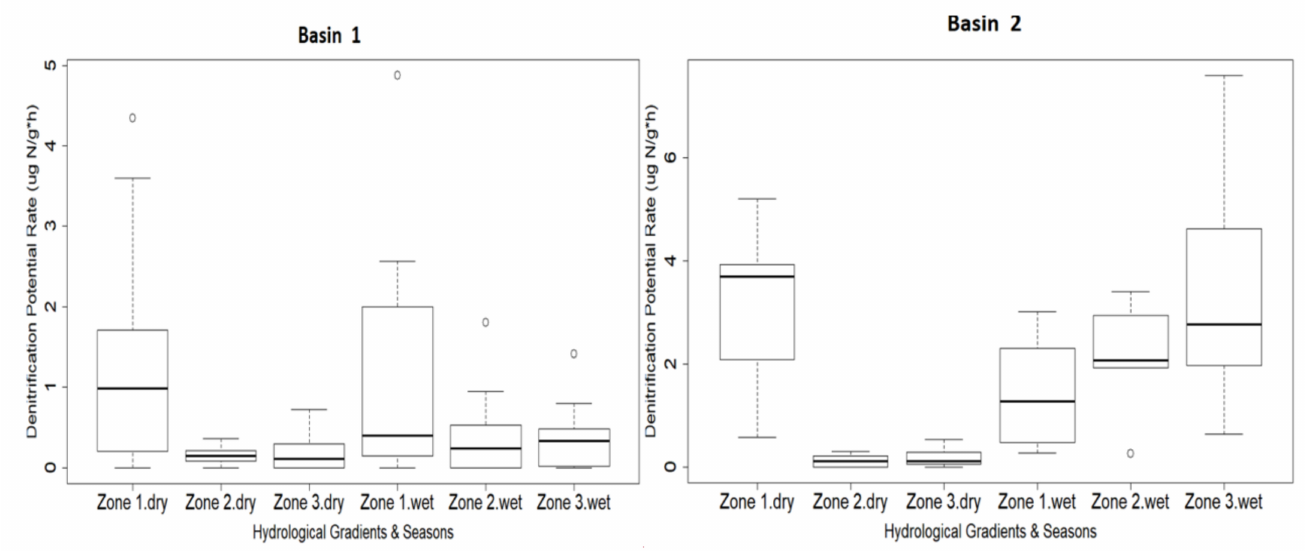
Figure 5. Potential dentrification rates in SIB soils by zones and seasons. Zone 1, frequently flooded; Zone 2, occasionally flooded; Zone 3, rarely flooded. Values represent data from the entire soil profile (all three sampling